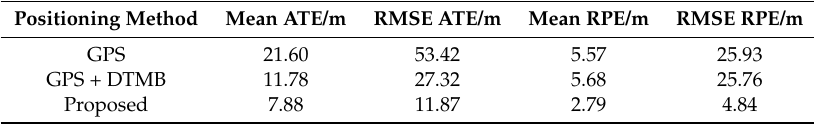
Table 6. Mean and RMSE value of ATE and RPE of different methods at Site